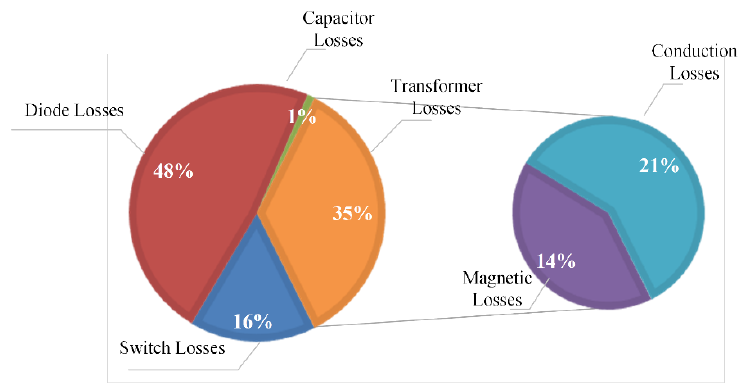
Figure 18. Loss contribution of the proposed converter at rated load.